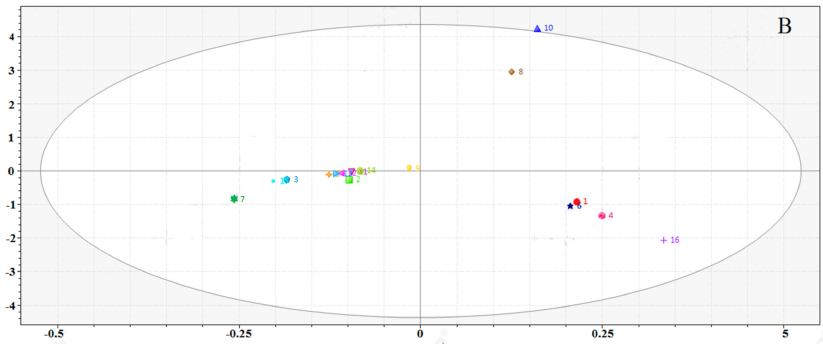
Figure 4. Principal component analysis (PCA) score plot of: ( A ) RXF; and ( B ) PXF.